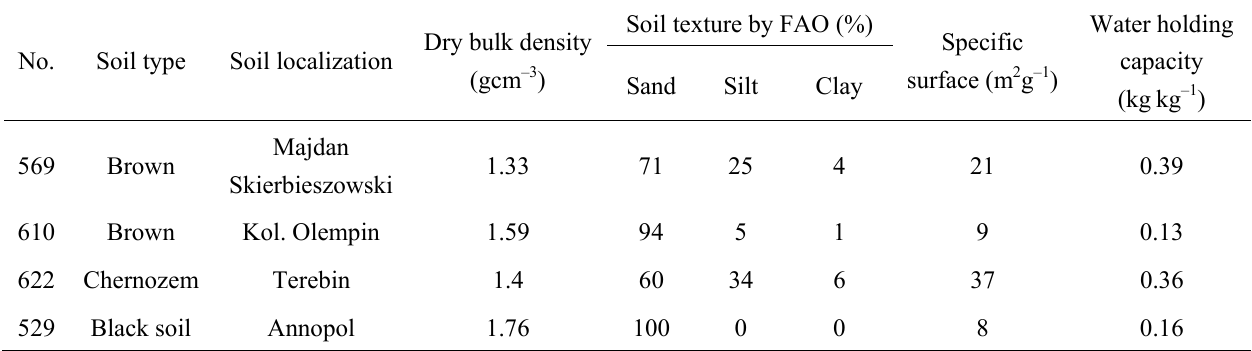
Table 1. Localization and selected physical parameters of tested